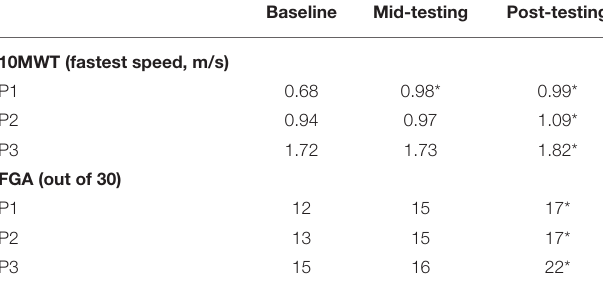
TABLE 3 | Clinical outcomes. Baseline Mid-testing